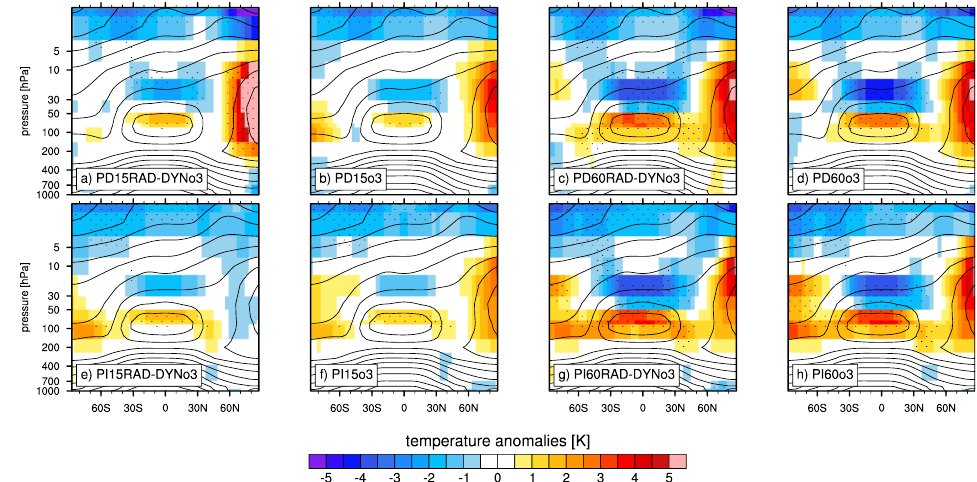
Figure 8. Similar to Fig. 5 but showing DJF zonal mean temperature anomalies (K) in the ozone sensitivity ensemble experiment. (top) Present day ensemble experiments forced by ozone changes from PD15_RAD-DYN (a) , PD15 (b) , PD60_RAD-DYN (c) , and PD60 (d) . (bottom) Same forcings but for the preindustrial experiments. Note the different colour scaling in comparison to Fig.